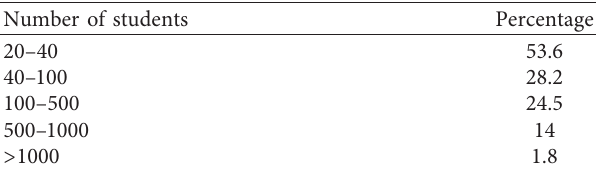
Table 4: Distribution of students by